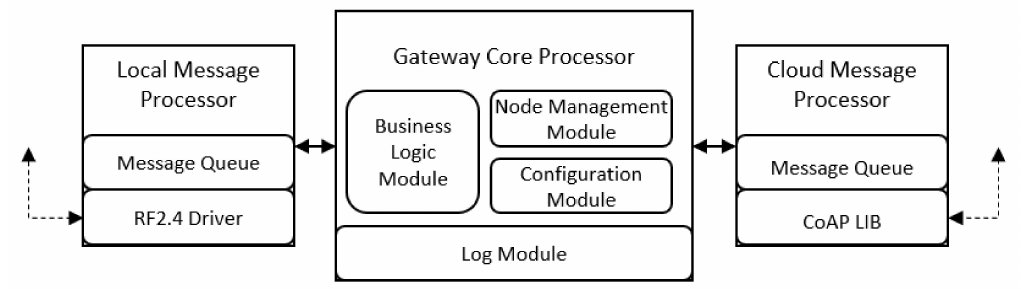
Figure 9. Software high-level design diagram of IoT